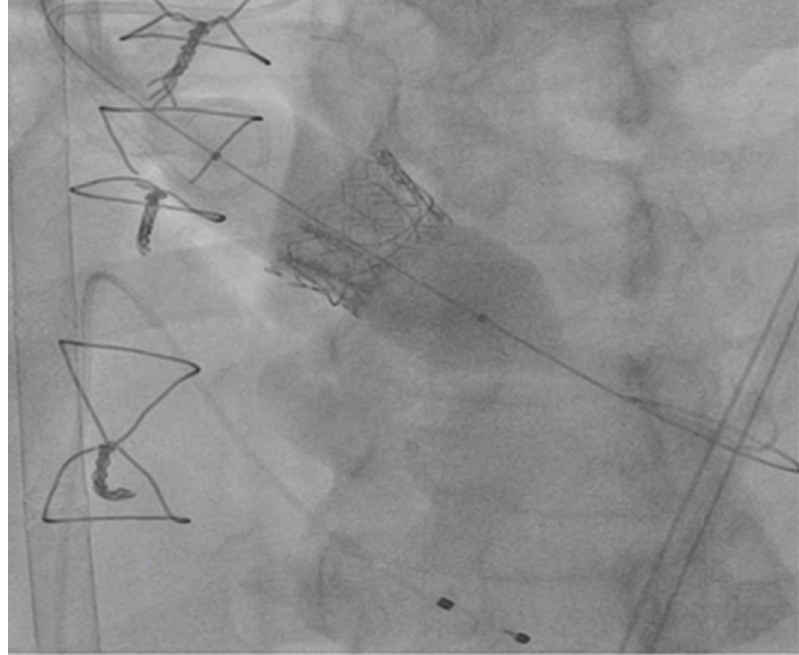
Figure 2. Left Anterior Oblique (LAO) Caudal View: True balloon fracturing the surgical bioprosthetic valve. The transvenous pacemaker in place.